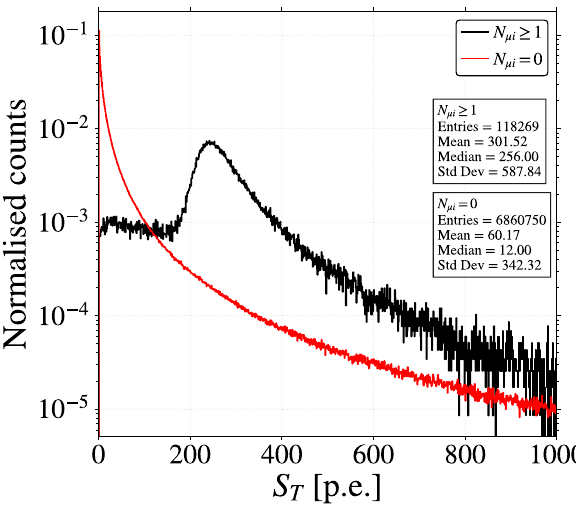
Fig. 4 Total collected signal (p.e.) in stations with (black line) and without (red line) muons, for proton induced air